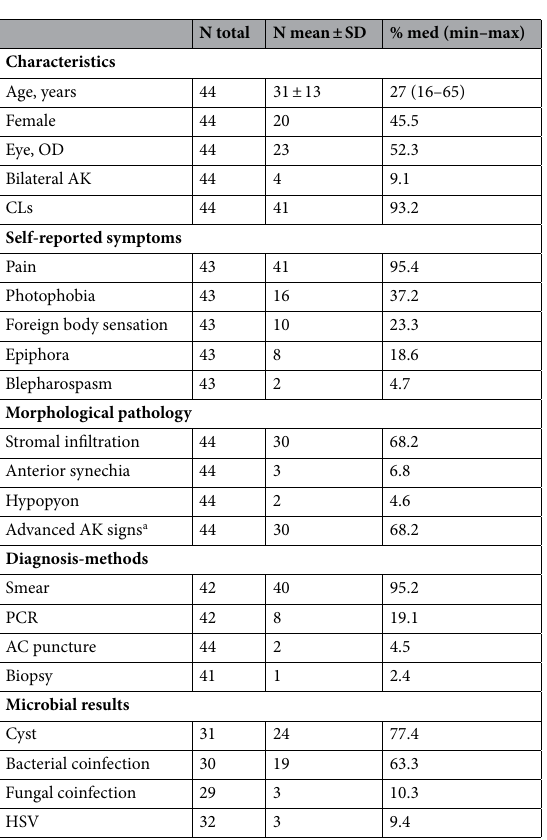
Table 1. Patient characteristics. a Defined as ≧ 1 of the following signs presented: ring infiltrate, stromal impairment, hypopyon; AC anterior chamber, AK acanthamoeba keratitis, CL contact lens, max maximum, med median, min minimum, N absolute number, PCR polymerase chain reaction, SD standard